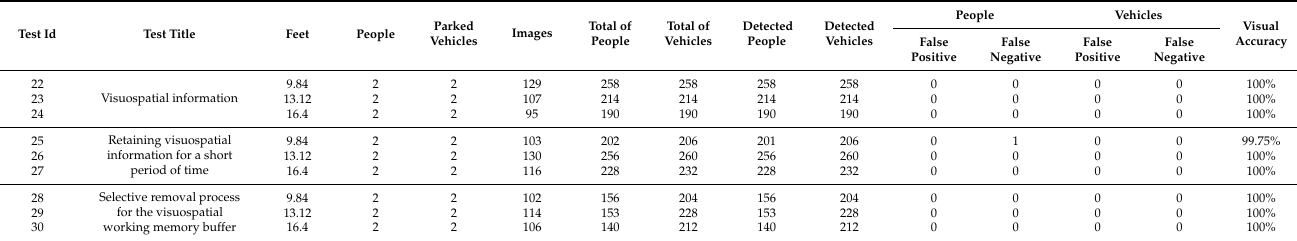
Table 7. Results of the third test